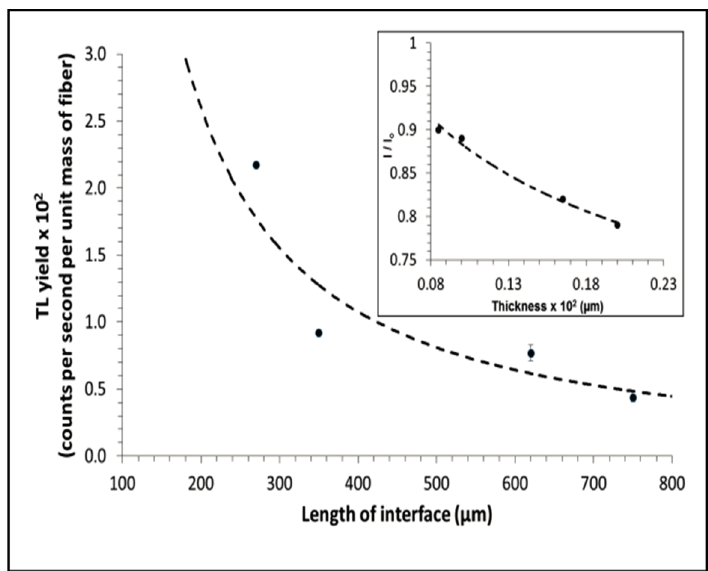
Figure 5. Calculated experimental TL yield per unit mass, mapped against the progressive increase in inner surfaces contact length. The inset shows an analysis of the effect of fiber transverse thickness on TL light transport, where I 0 and I are the intensity (power per unit area)